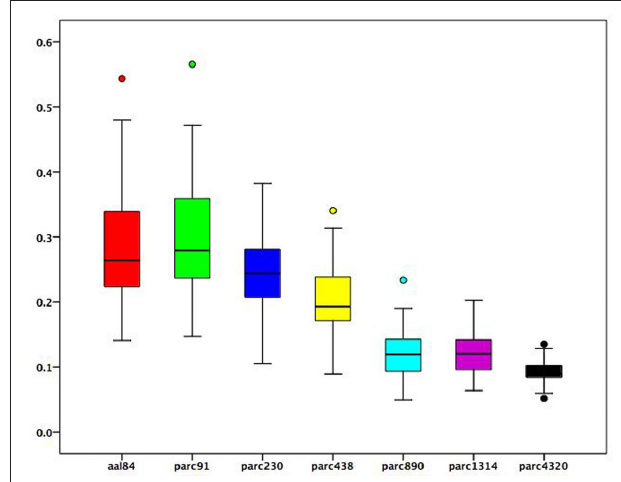
FIguRe 3 | Boxplots of subject-specific correlations between mean regional functional connectivity and regional volumes at each parcellation scale. Boxes represent the inter-quartile range, heavy horizontal lines the median. Whiskers represent the 5th and 95th percentiles. Circles represent values beyond these percentiles.